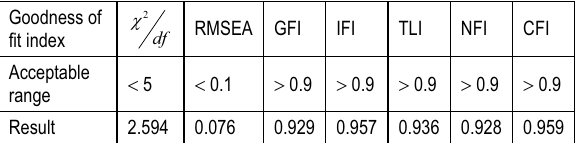
Table 5. Goodness of fit indices of the modified